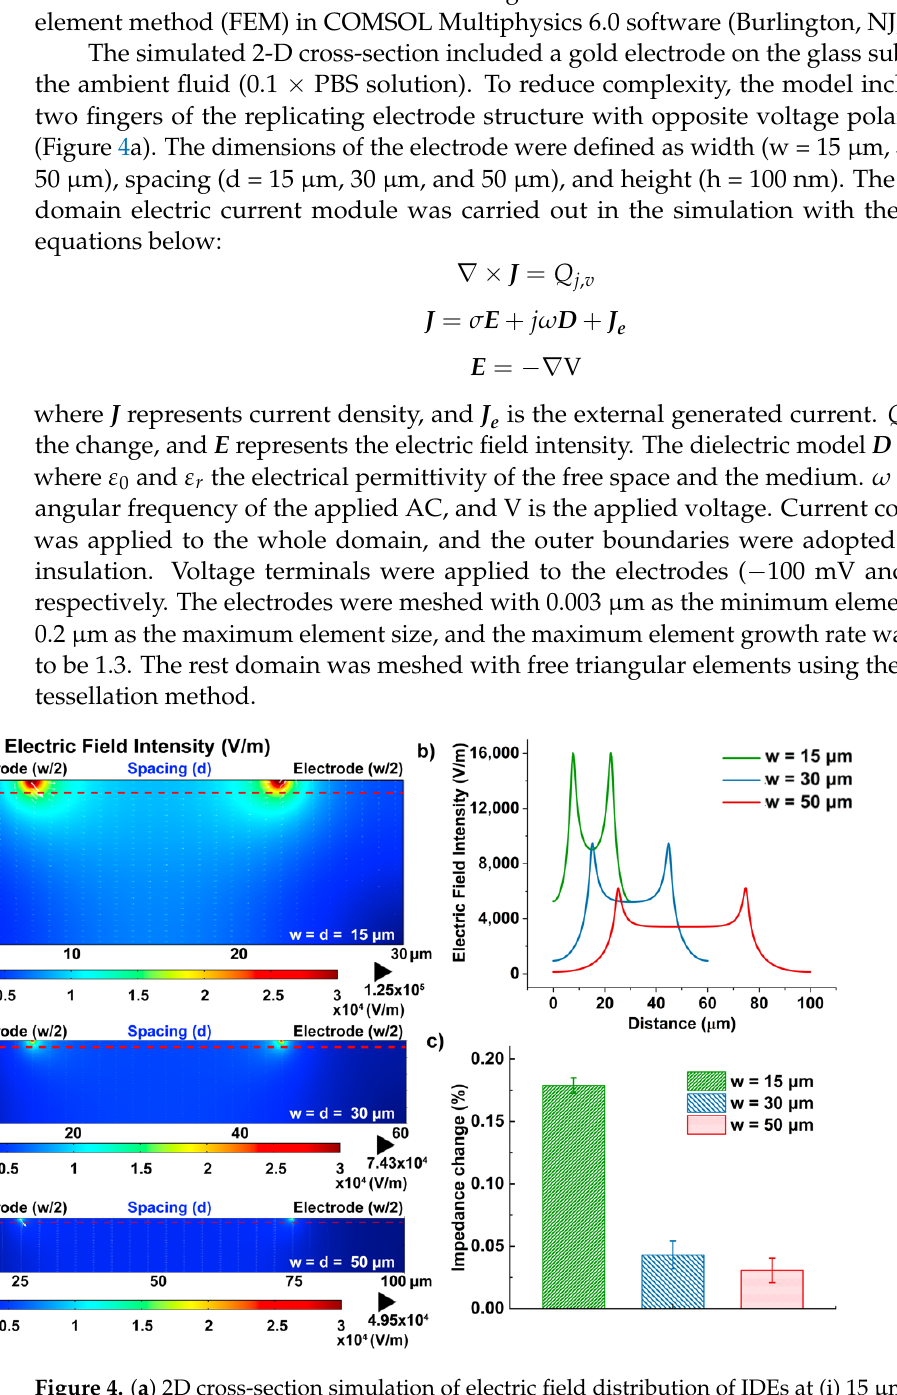
Figure 4. ( a ) 2D cross-section simulation of electric field distribution of IDEs at ( i ) 15 μ m; ( ii ) 30 μ m; ( iii ) 50 μ m; ( b ) Electric field intensity at 1 μ m below the electrode surface (corresponding to red dotted lines in Figure a ); ( c ) Experimental analysis of the impedance measurement performance in terms of the dimension of the IDEs, with error bars denoting standard deviation of n = 3.